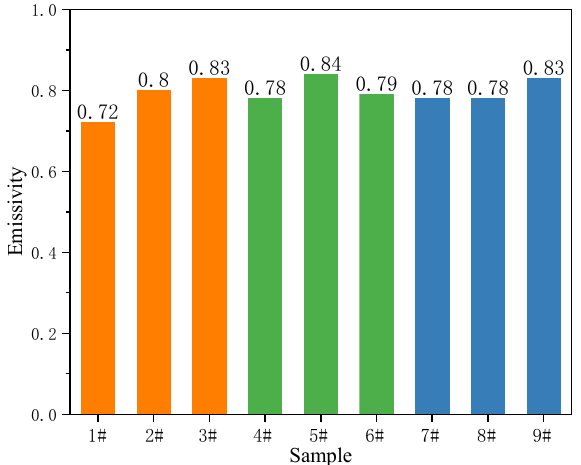
Figure 10. The hemisphere emissivity of black MAO coating samples 1 # –9 # .